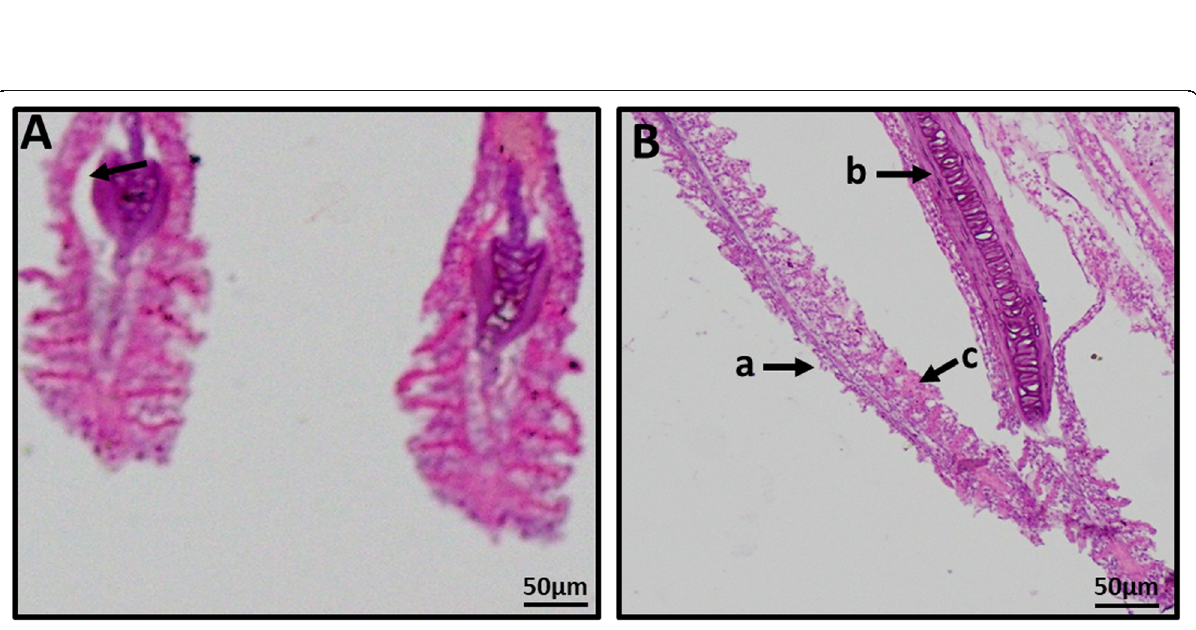
Fig. 5 Photomicrographs of gills of Heteropneustes fossilis after 7-day exposure to 0.0075 ppm Envoy 50 SC. a vacuolation and b missing of secondary gill lamellae (a), hyperplasia (b), and clubbing (c) were observed